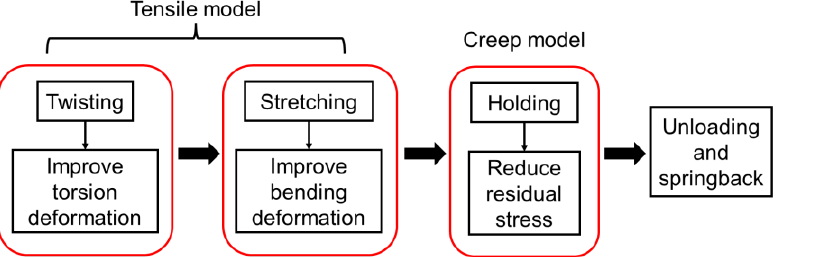
Figure 12. The flow chart of the numerical simulation procedure.